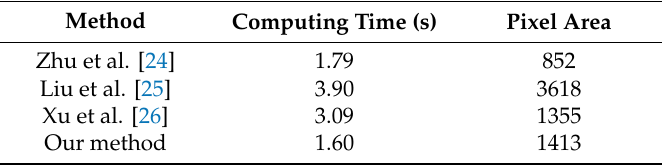
Figure 23. Decision matrix for effective wave area. Table 5. Comparison of the computing time and identified pixel area.